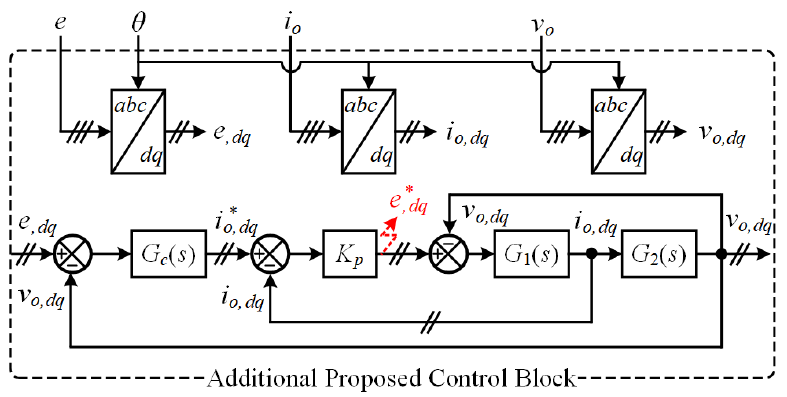
Figure 6. Block diagram of additional proposed control